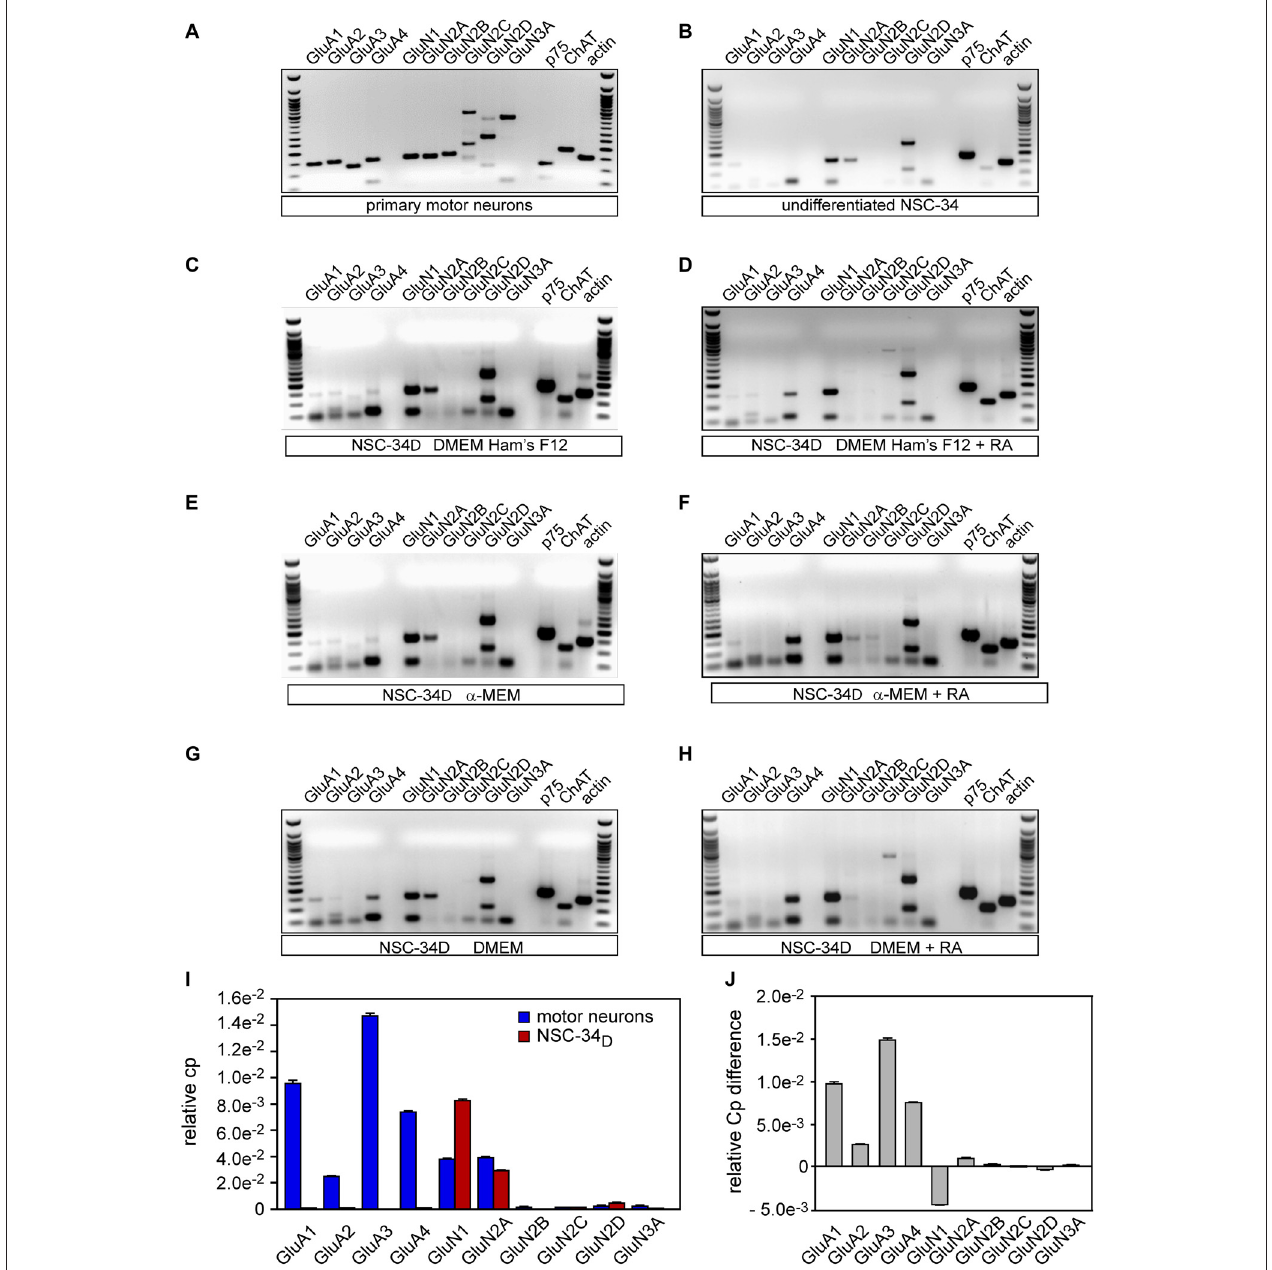
FIGURE 2 | Characterization of the expression of glutamatergic receptors in motor neurons (MNs) and NSC-34 D cells . Conventional RT-PCR on RNA isolated from NSC-34 cells maintained in the proliferation medium (undifferentiated) (A) , from MNs (B) , and from NSC-34 cells grown in three differentiation media with or without all trans -retinoic-acid (AR) for 4 weeks: (C,D) DMEM/Ham’s F12, (E,F) MEM and (G,H) DMEM. (I) Semi-quantitative RT-qPCR analysis of gene expression of glutamate receptor subunits in MN and NSC-34 differentiated in DMEM/Ham’s F12 media without RA (mean ± SEM, n = 3). (J) Semi quantification of the differences in RT-qPCR between MN and NSC-34 D in DMEM/Ham’s F12 media without RA (mean ± SEM, n =